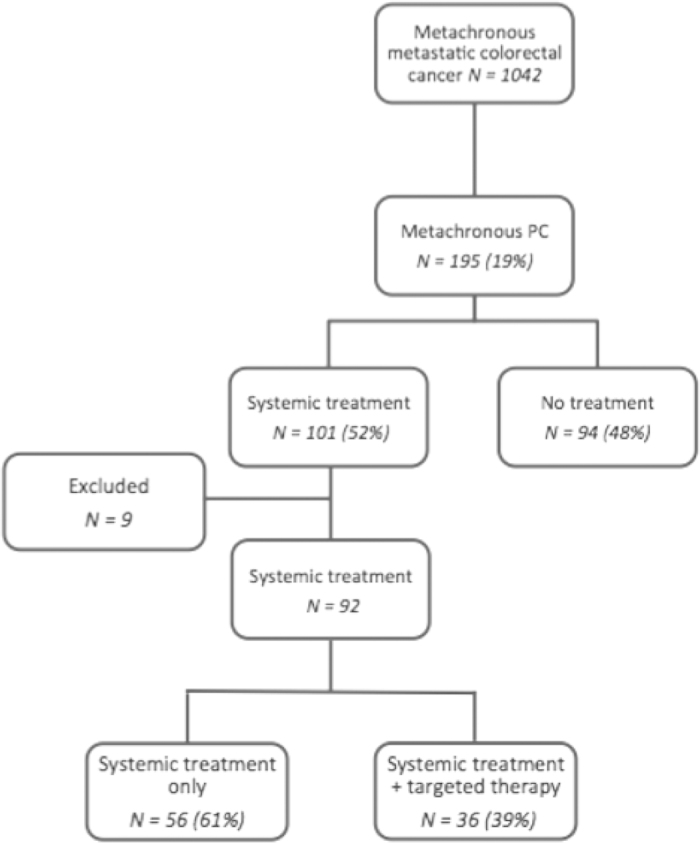
Study population.